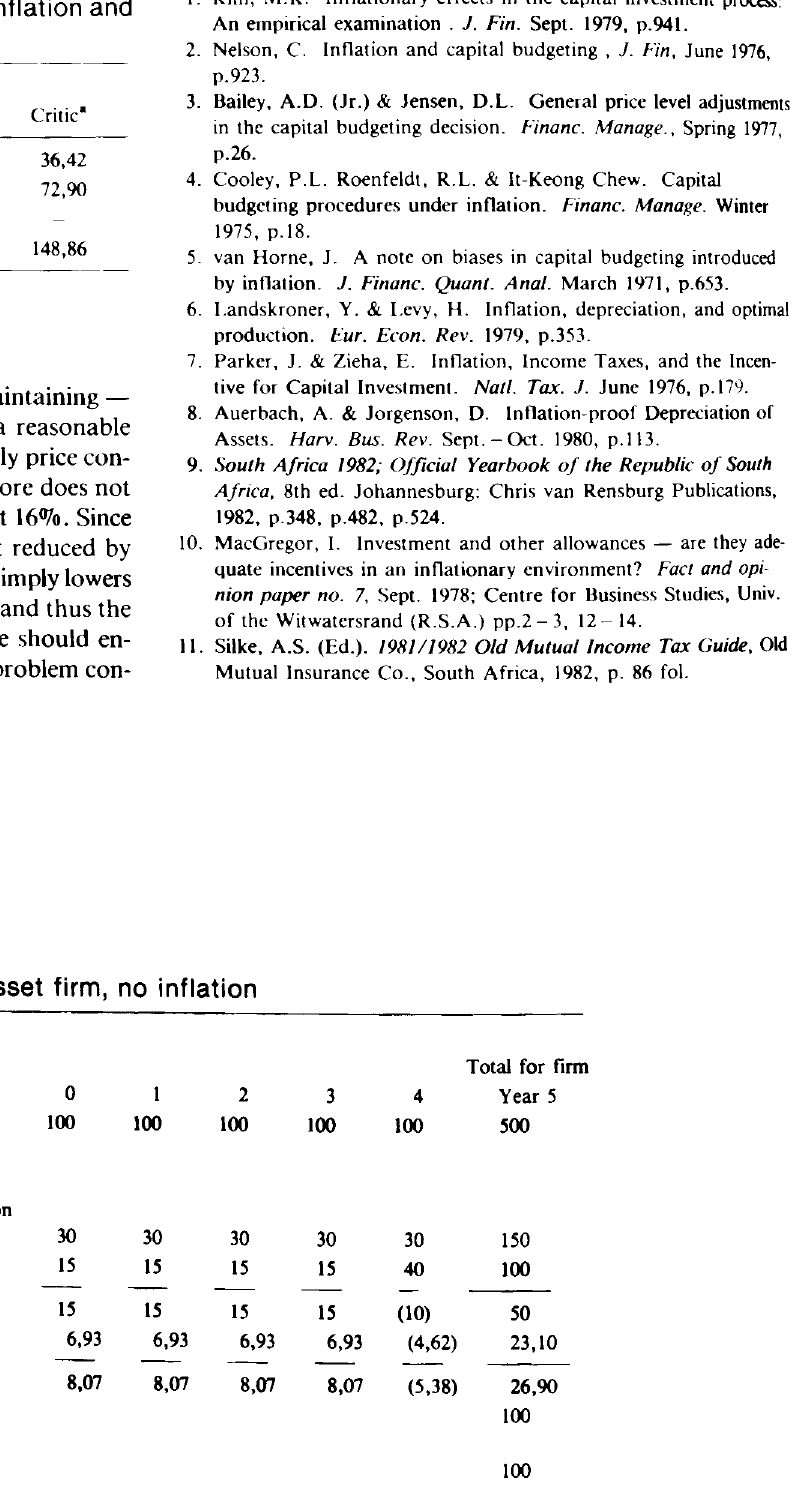
A comparison of M estimates of required allowances at 8% inflation and no